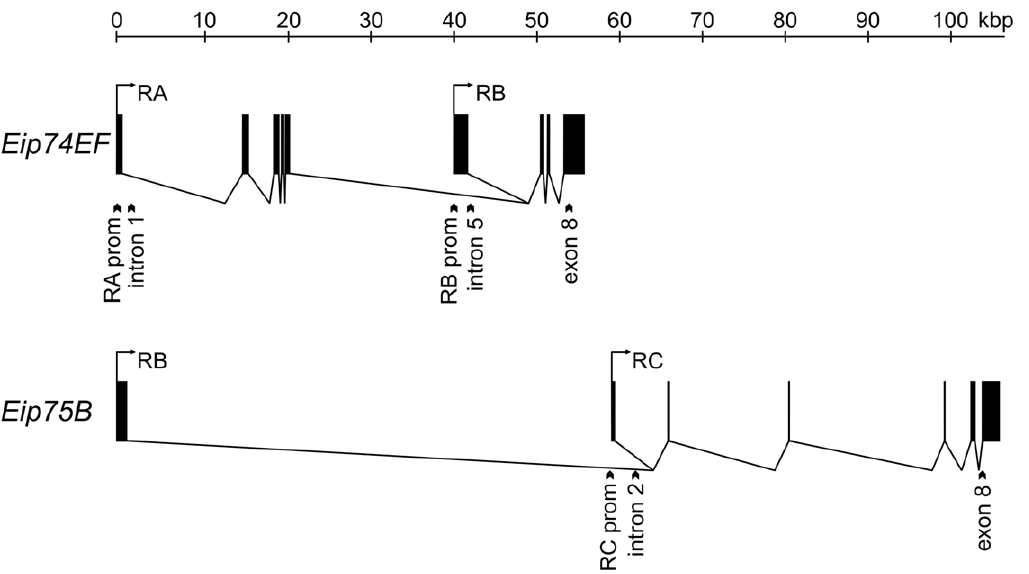
Figure 1. Gene models of the Eip74EF and Eip75B genes. Characteristic transcript variants of the two genes are shown and labeled based on the Drosophila genome annotation by FlyBase [51]. Exons are represented by solid rectangles, promoters are marked by arrows. Arrowtails show the position of amplicons detected in Q-PCR based transcript analysis and ChIP assays. These amplicons fall to the following regions: Eip74EF-RA promoter (RA prom), Eip74EF-RA 5 9 transcribed region (intron 1), Eip74EF-RB promoter (RB prom), Eip74EF-RB 5 9 transcribed region (intron 5), Eip74EF 3 9 transcribed region (exon 8), Eip75B-RC promoter (RC prom), Eip75B-RC 5 9 transcribed region (intron 2) and Eip75B-RC 3 9 transcribed region (exon 8). The sequences and chromosomal location of primers are in Table S1.